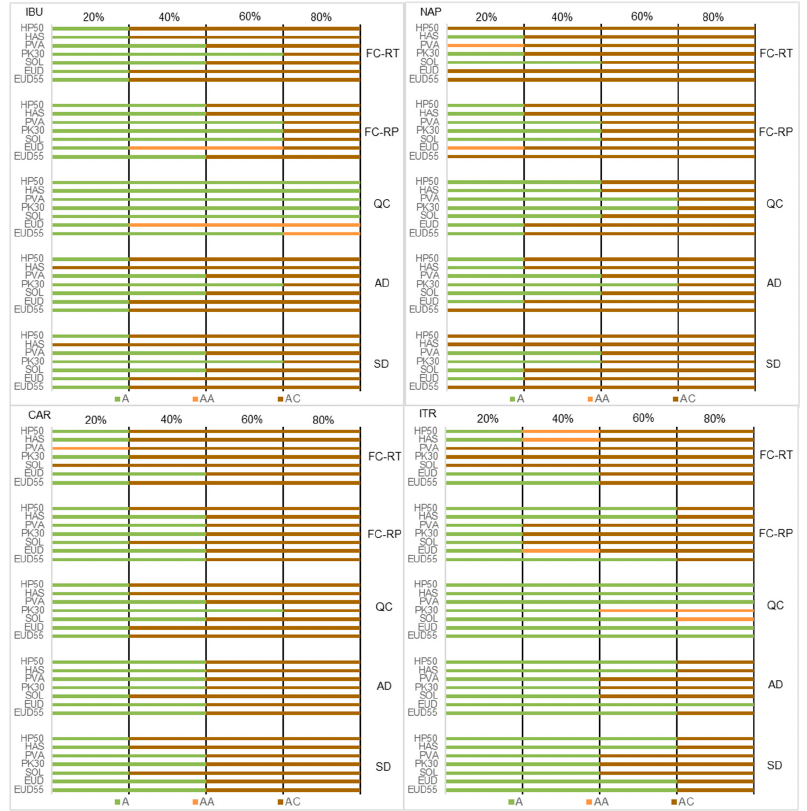
Figure 6. Phase behavior of IBU, NAP, CAR, and ITR amorphous solid dispersions (ASDs) (from top to bottom) produced by film casting (FC) performed: at RT (FC-RT) and under reduced pressure (FC-RP); (QC) quench cooling, (AD) atomization screening device, and (SD) spray dryer as a function of drug loading (DL) for the set of polymers tested. A: ideal amorphous glass solution; AA: amorphous phase-separated sample; AC: sample with the presence of residual crystallinity.